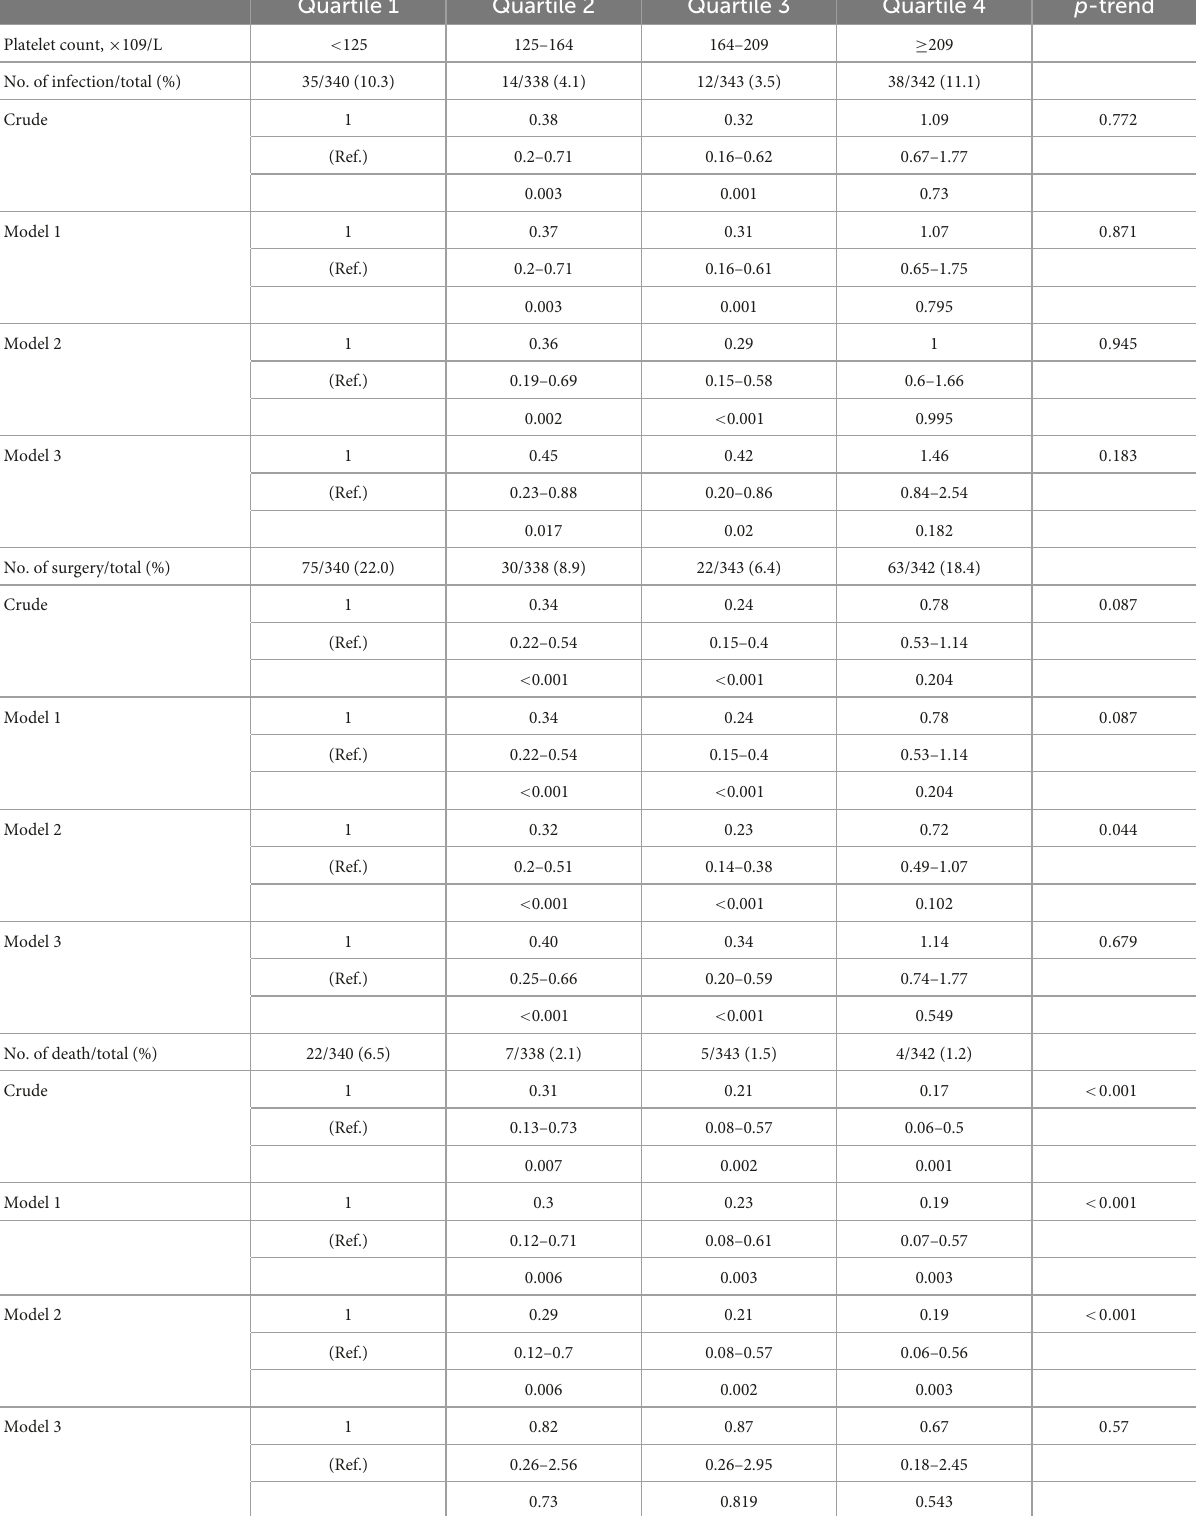
TABLE 2 Association between platelet count and risk of intra-abdominal infection, surgical intervention, and in-hospital mortality estimated using logistic regression models. Quartile 1 Quartile 2 Quartile